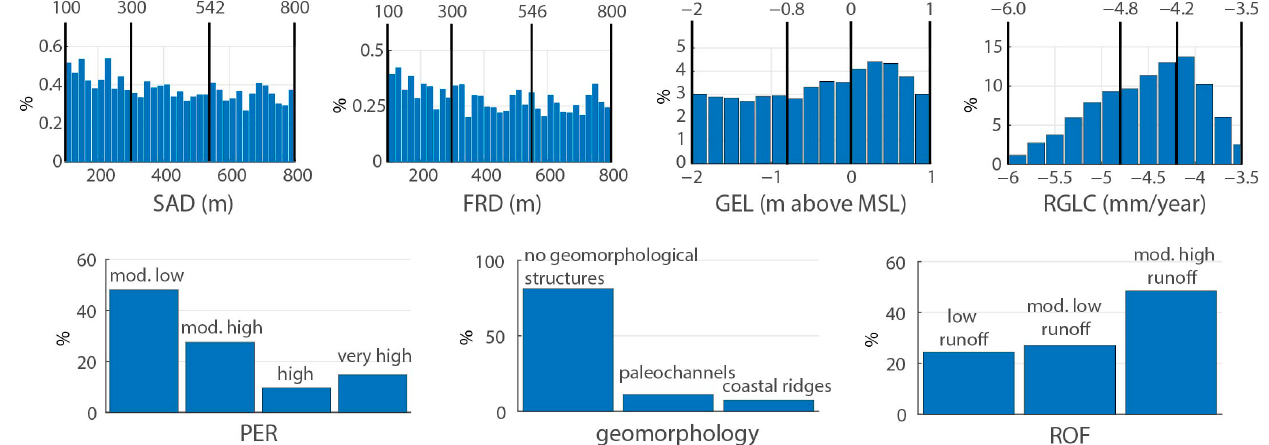
Figure 4. Frequency distribution of each sensitivity layer in the dataset (i.e., percentage of nodes in each thematic layer class over the total amount of nodes considered in the study area) confined within the minimum and the maximum boundaries set for scores 0 and 4, respectively. The abbreviation mod. means moderately, the acronym MSL stands for mean sea level.